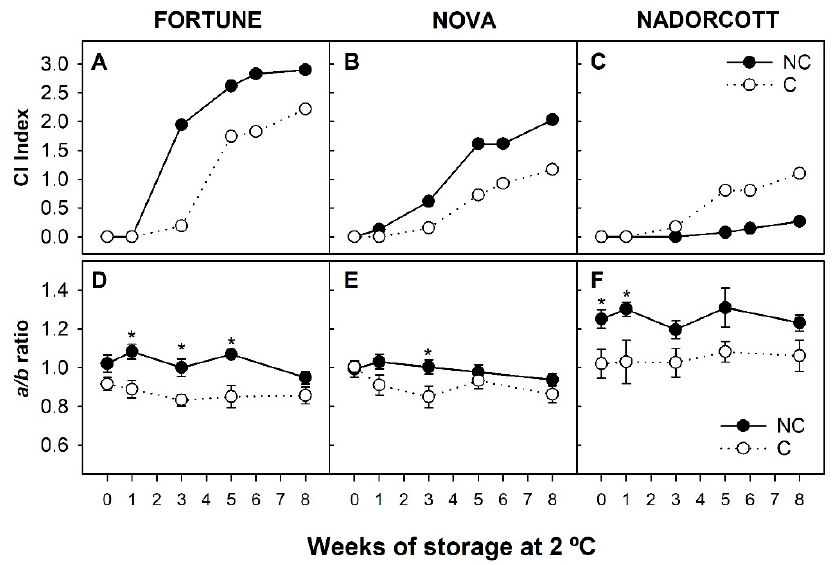
Figure 2. Development of chilling damage expressed as the CI index of non-covered (NC) and covered (C) fruit of Fortune ( A ), Nova ( B ), and Nadorcott ( C ); and rind color expressed as a/b ratio of non-covered (NC) and covered (C) fruit of Fortune ( D ), Nova ( E ), and Nadorcott ( F ), at harvest (0) and during storage at 2 °C. Asterisks indicate significant differences between NC and C fruit for each cultivar and sample date ( p ≤ 0.05, t- test).